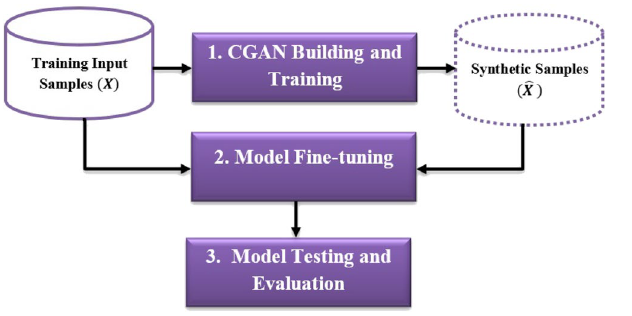
Figure 6. The proposed framework for enhancing the performance of transfer learning models in few-shot HCR